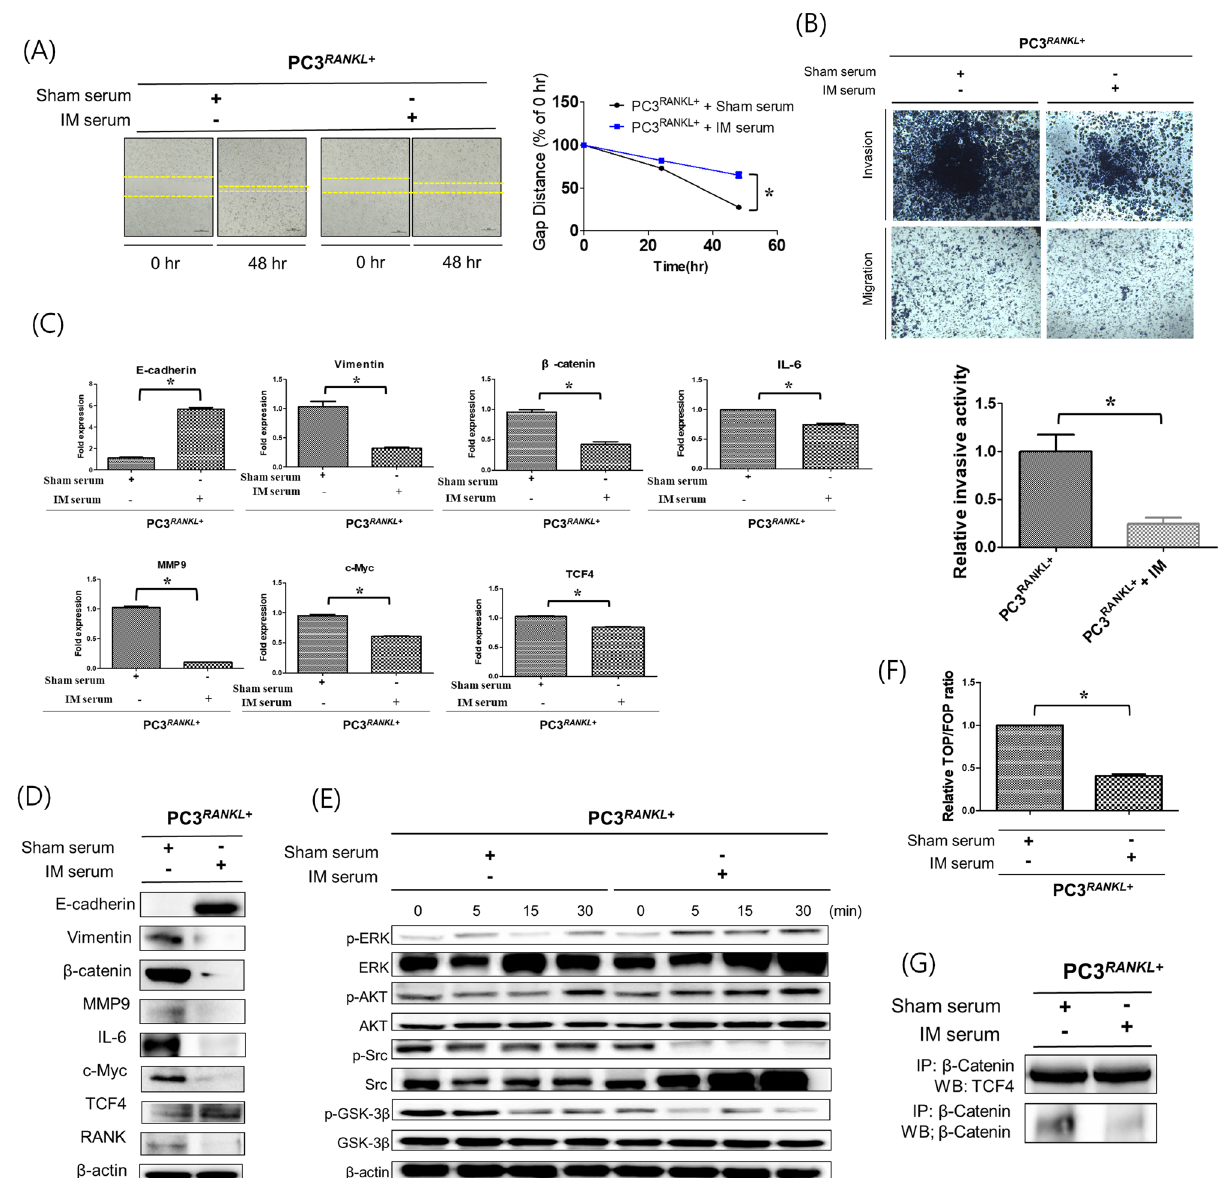
Figure 5. EMT and metastatic properties of PC3 cells treated with immune sera. ( A ) Cell migration assays were performed to compare the wound healing capacity of immune serum-treated PC3 RANKL+ cells and untreated cells. Immune serum treatment decreased the migration capacity of PC3 cells, as evident from the increase in the wound healing gap at 48 h. Magnification, × 100; scale bar, 100 μm. Data from related graphs are displayed as the mean ± SD. ( B ) Transwell invasion assays were performed to compare the invasiveness of immunised serum-treated PC3 RANKL+ and untreated cells. Serum-treated PC3 RANKL+ cells showed a significant decrease in invasiveness. Magnification, × 100; scale bar, 100 μm. Data in the associated graphs are expressed as the mean ± SD. ( C ) Real-time quantitative polymerase chain reaction for the analysis of EMT and metastasis markers in PC3 RANKL+ cells. β-Actin was used as a loading control. Significant differences were observed at *p < 0.05, compared with the control. ( D ) Expression of E-cadherin, Vimentin, β-catenin, MMP-9, IL-6, c-MYC, TCF-4 and β-actin in immune serum-treated PC3 RANKL+ cells, as measured by western blotting. β-Actin was used as a loading control. Similar results were obtained in three independent experiments. ( E ) Western blot analysis of MAPK phosphorylation levels in serum-treated PC3 RANKL+ cells. Similar results were obtained in three independent experiments. ( F ) TOP/FOP luciferase reporter assays in immune serum-treated PC3 RANKL+ cells. Significant differences were observed at *p < 0.05 vs. the control. ( G ) Co-immunoprecipitation of β-catenin and TCF-4 from PC3 RANKL+ and immune serum-treated PC3 RANKL+ cells. Each blot was obtained under the same experimental